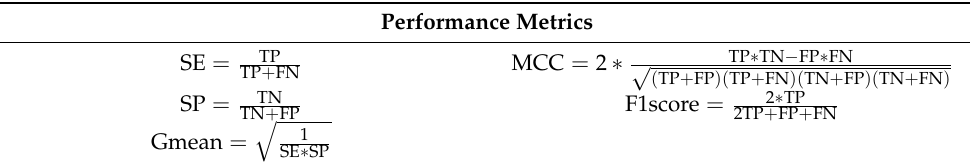
Table 1. Equations of the performance metrics